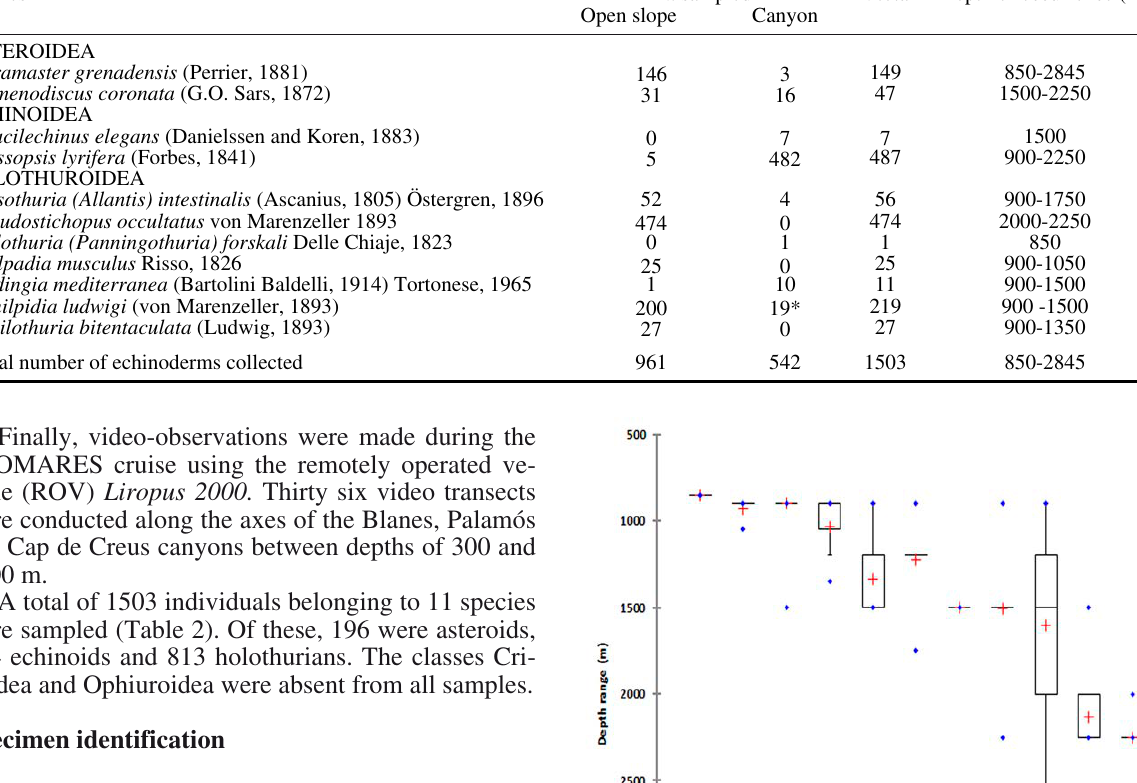
Table 2. – Echinoderms sampled in the present study from the deep Mediterranean Sea. * 19 specimens of P. ludwigi were collected in sedi- ment trap samples in the Blanes Canyon. Species N. sampled